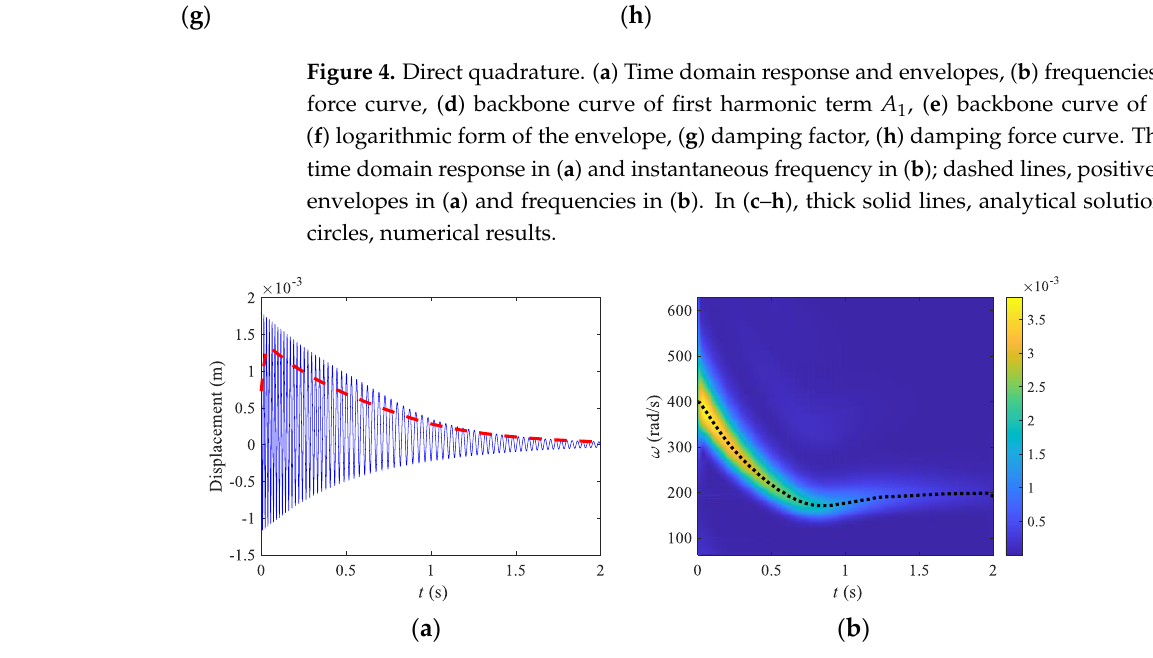
( g ) Figure 5. Wavelet transform. ( a ) Time-domain response and envelope, ( b ) spectrogram, ( c ) back- bone curve of first harmonic term A 1 , ( d ) backbone curve of bias term A 0 , ( e ) logarithmic form of the envelope, ( f ) damping factor, ( g ) damping force curve. Thin solid line, time domain response; dashed line, envelope; dotted line, instantaneous frequency; thick solid lines, analytical solutions; lines with circles, numerical results.